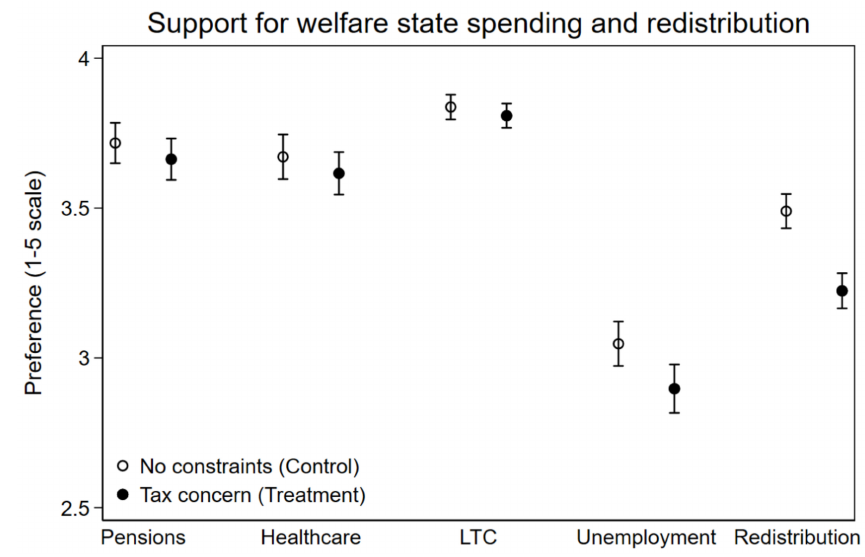
Figure 1. The effect of tax concerns on support for welfare state spending and